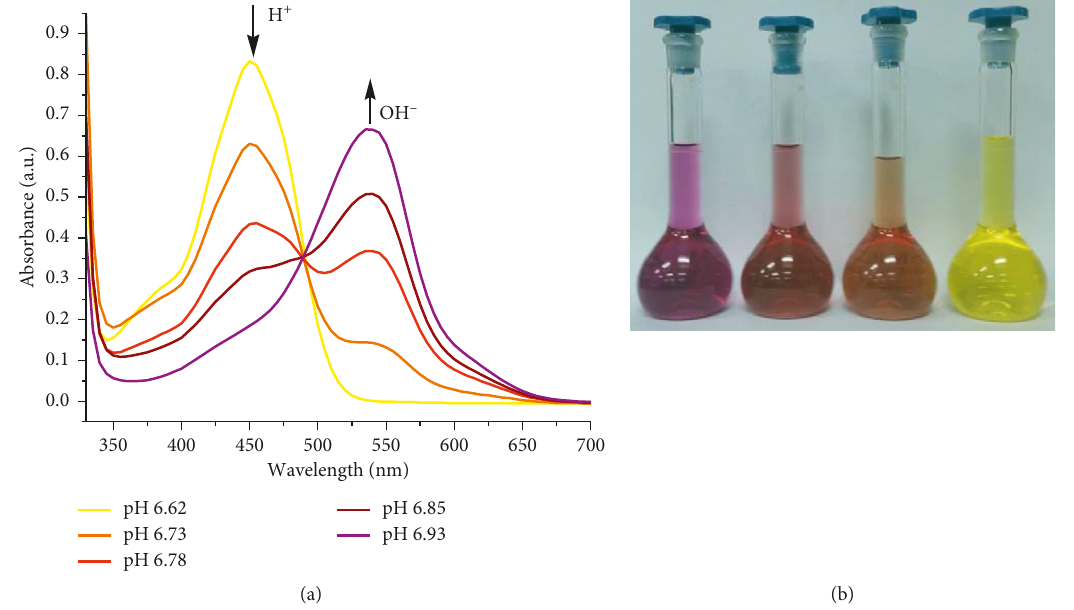
Figure 3: UV-Vis absorption spectra (a) and the corresponding color variations (b) of the hydrazone dye 1 in acetonitrile ( ca. 2.3 × 10 − 5 mol · L − 1 ) at a range of pH values (6.62–6.93).